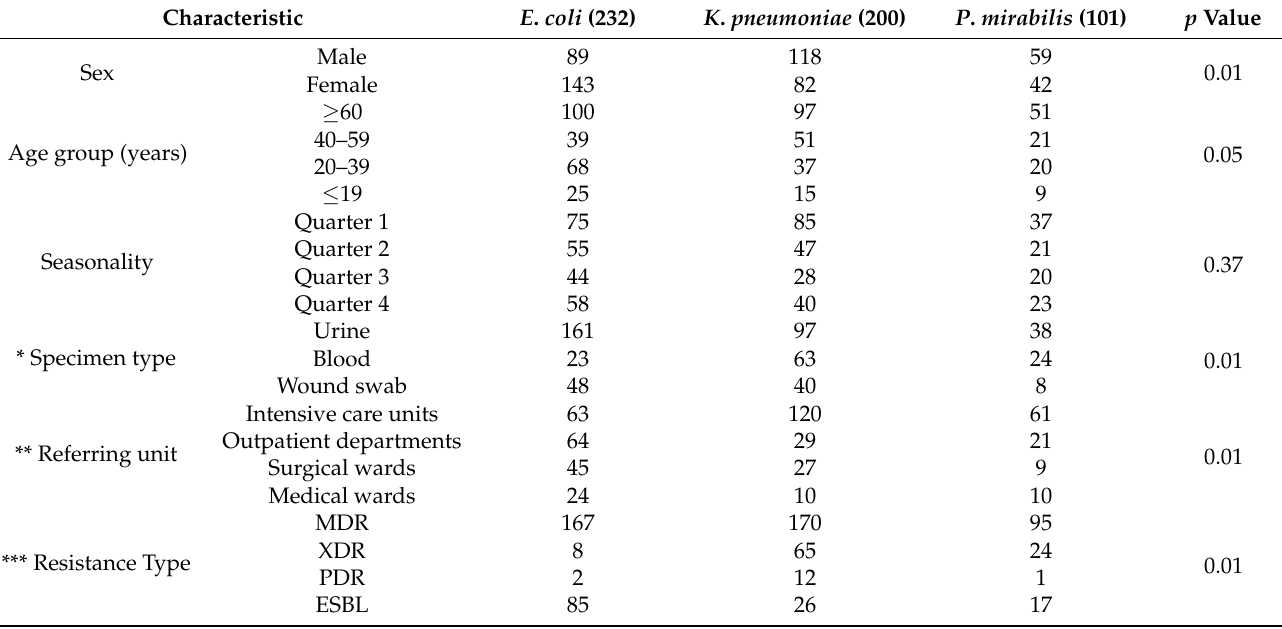
Table 1. Distribution characteristics and resistance profile in E . coli , K . pneumoniae , and P . mirabilis ( n = 533).